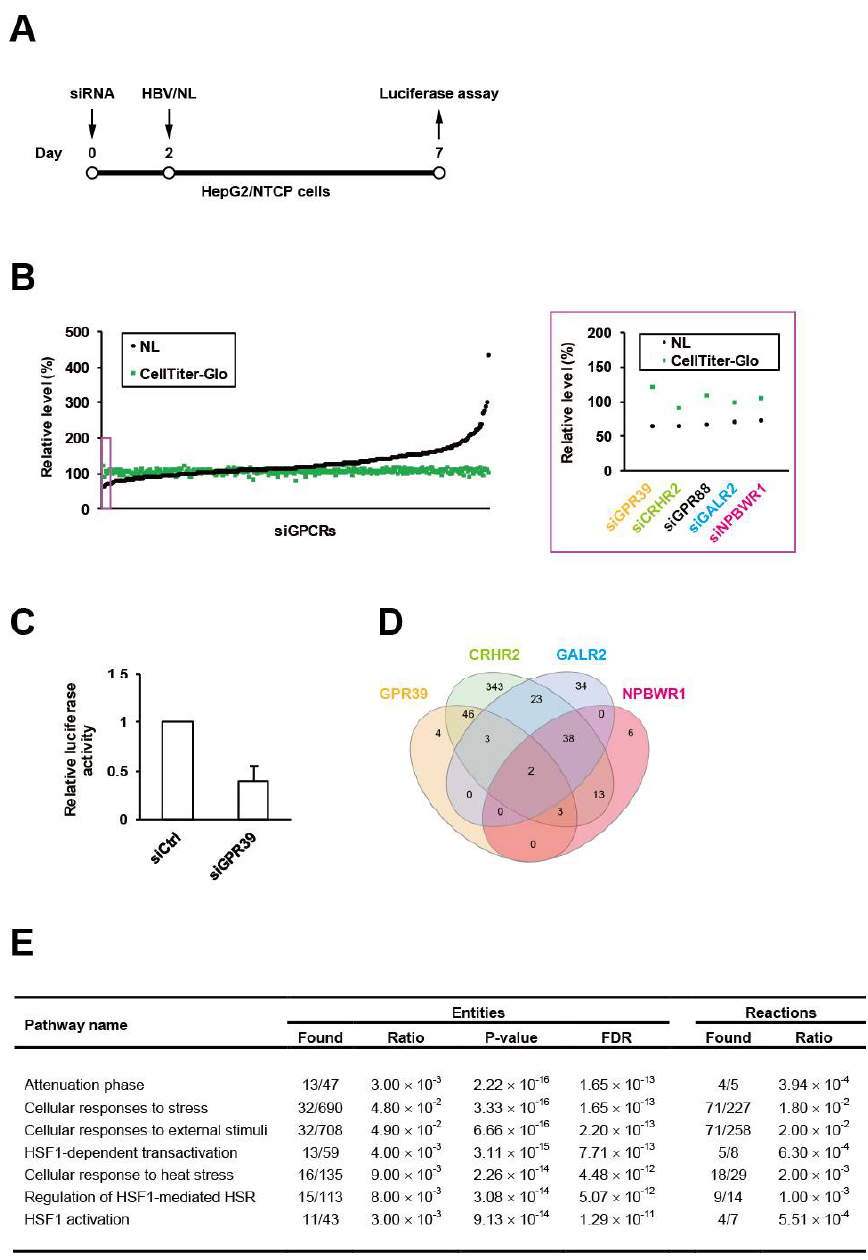
Figure 1. An RNAi screen of GPCRs for HBV proliferation. HepG2/NTCP cells were infected with HBV/NL at 5 days after the transfection of siRNAs to GPCRs for 2 days followed by the measurement of luciferase activities ( A ), and the relative levels of HBV and cell viability were indicated by NL and CellTiter-Glo, respectively, with the effects of knockdown of the top 5 genes highlighted by a purple rectangle and magnified on the right ( B ); the effect of GPR39 knockdown on HBV proliferation was demonstrated separately in a bar graph ( C ). ( D ) The Venn diagram of genes regulated by GPR39, CRHR2, GALR2 and NPBWR1. ( E ) Top significant pathways connected to the GPR39-GSK3B axis.